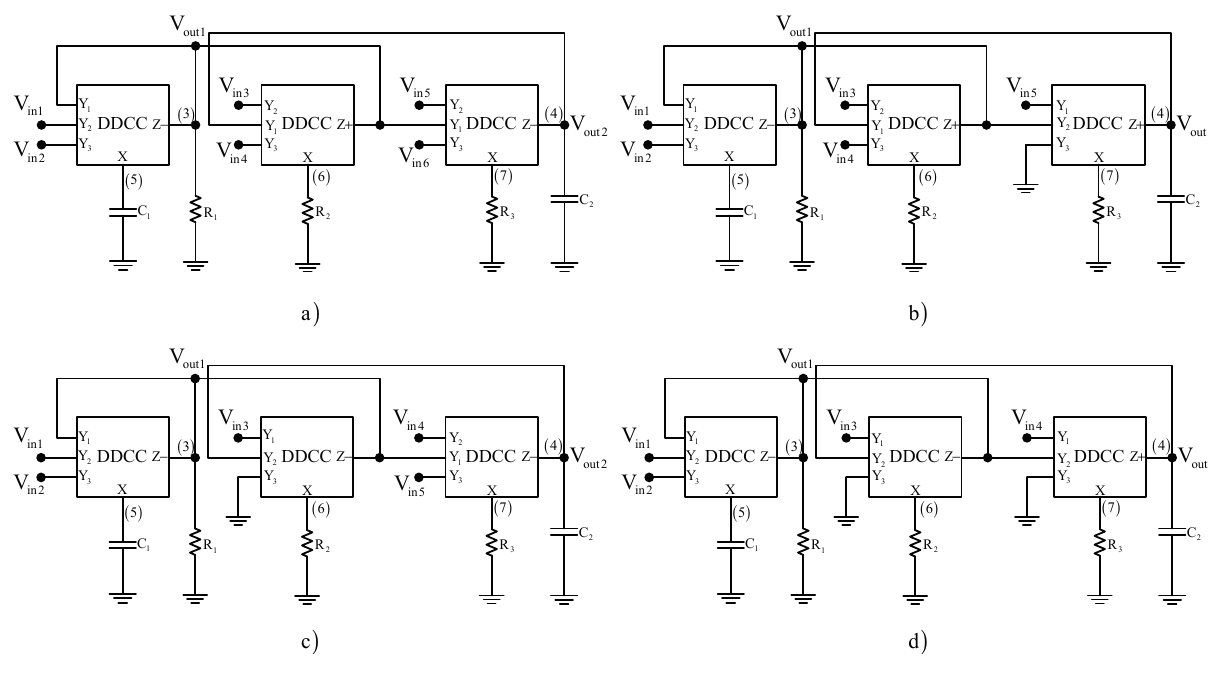
Figure 4. The pathological representations of derived type-A filters (cases